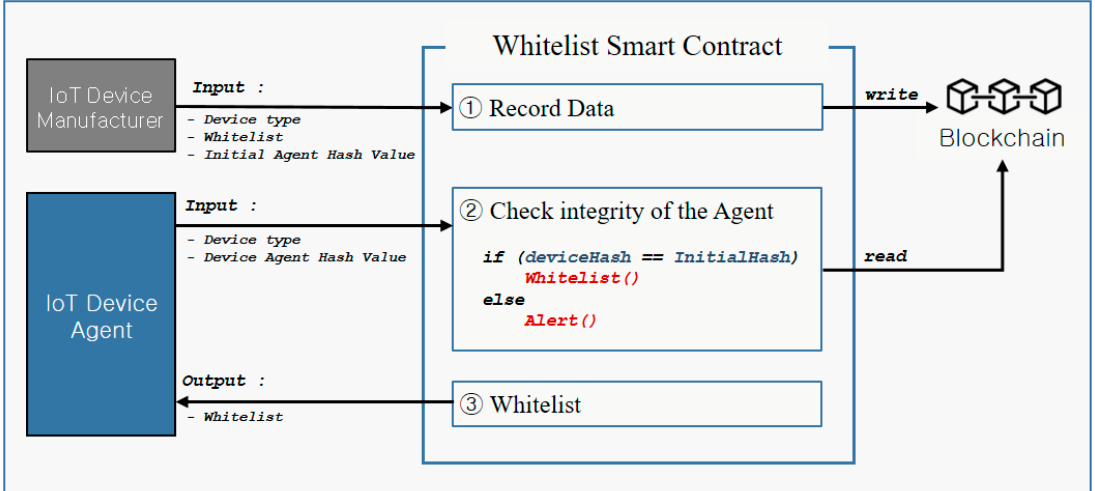
Figure 4. Whitelist smart contract.